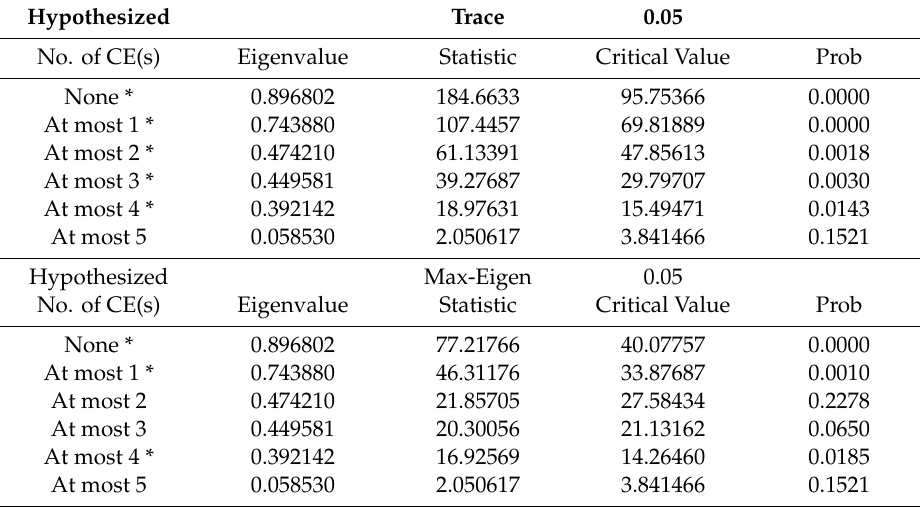
Table 6. Johansen cointegration test using Trace statistics and Max–Eigenvalue statistics. Hypothesized Trace 0.05 Statistic